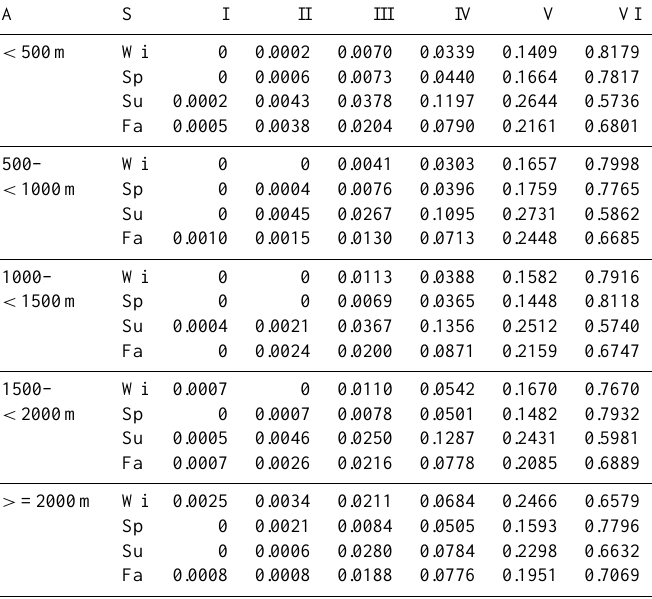
Table D5. Probabilities of cloud coverage classes for a 24h precipitation sum of > 10–20cm depending on explanatory variables following selected Swiss climate stations. For further description see Table